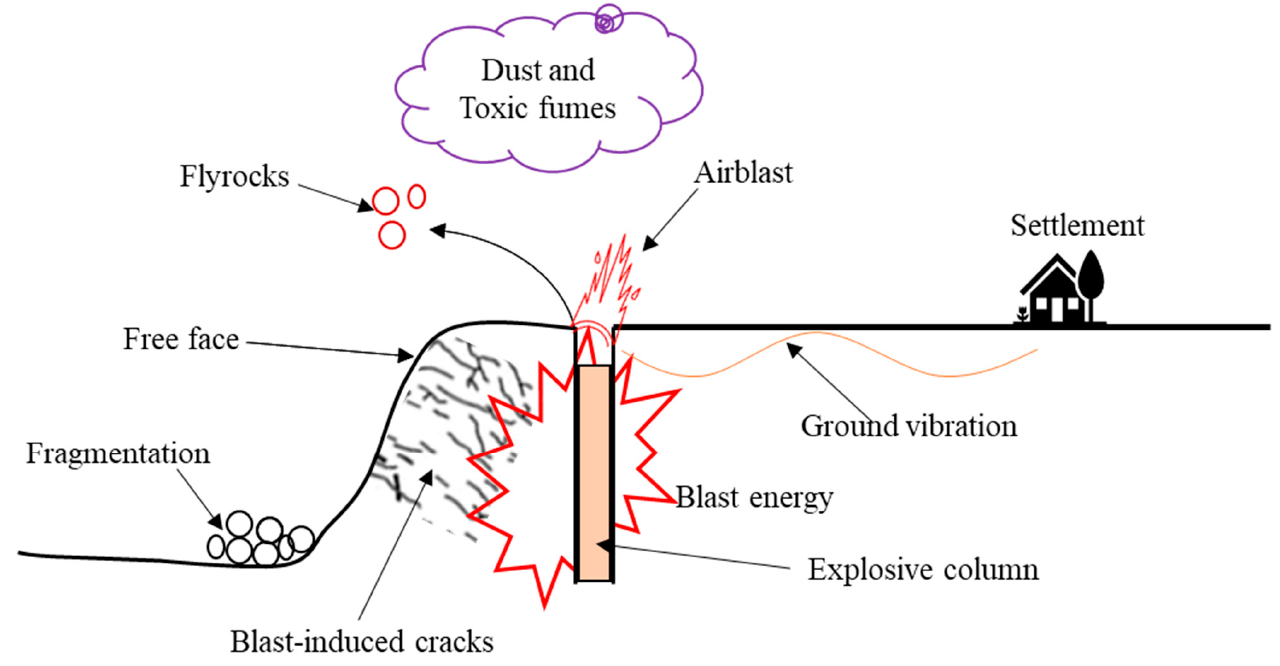
Figure 6. Blast waves and impacts.